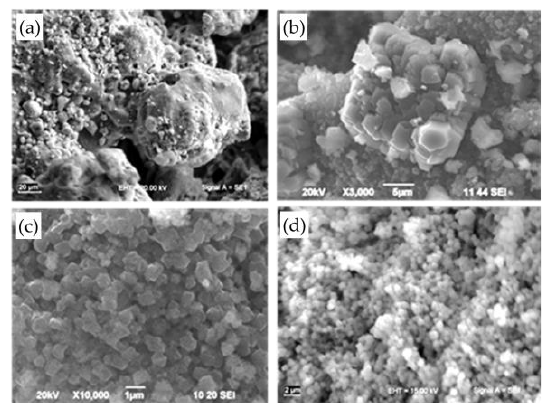
Figure 3. SEM images of raw FA ( a ) and FAZs synthesized by atmospheric crystallization ( b ), fusion – hydrothermal synthesis with magnetic stirring ( c ), and ultrasonic homogenization ( d